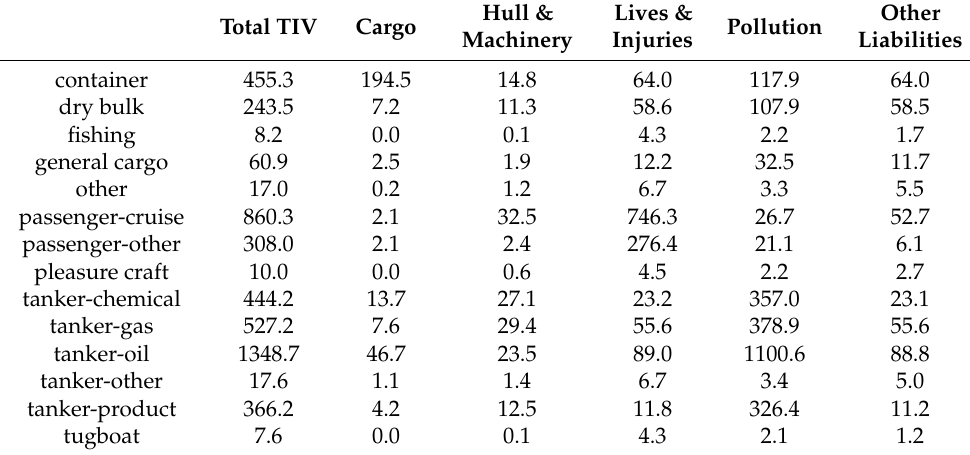
Table A2. Mean TIV values by major ship type, USD (millions), 2017 to 2020.